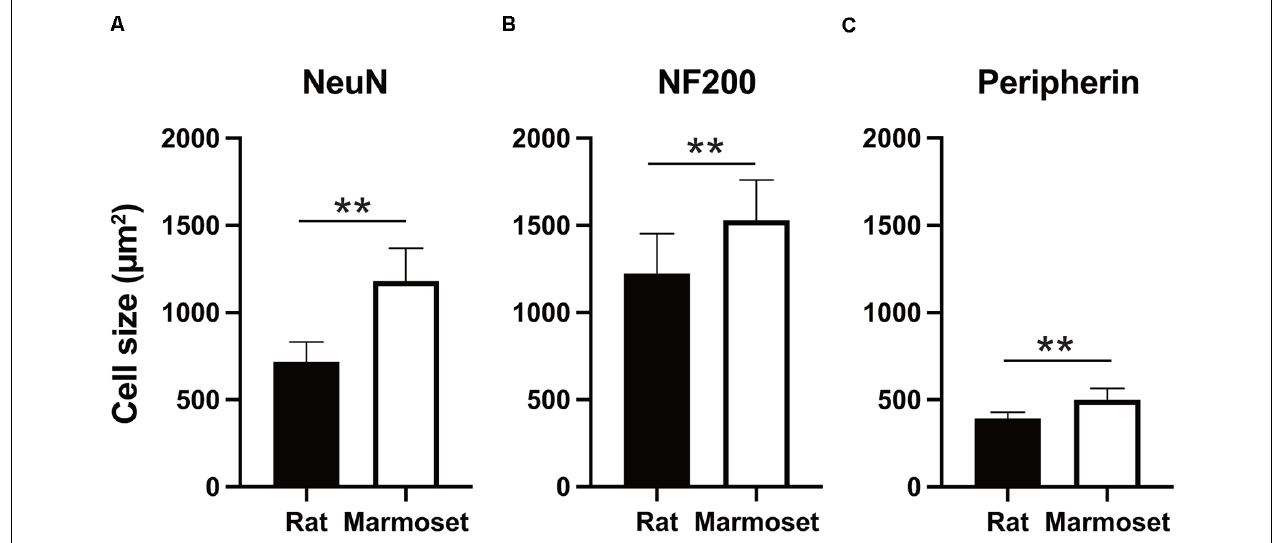
FIGURE 3 | Cell size comparison. Comparison of the size of NeuN- (A) , NF200- (B) , and peripherin-positive cells (C) between rats and marmosets. ** p < 0.01.